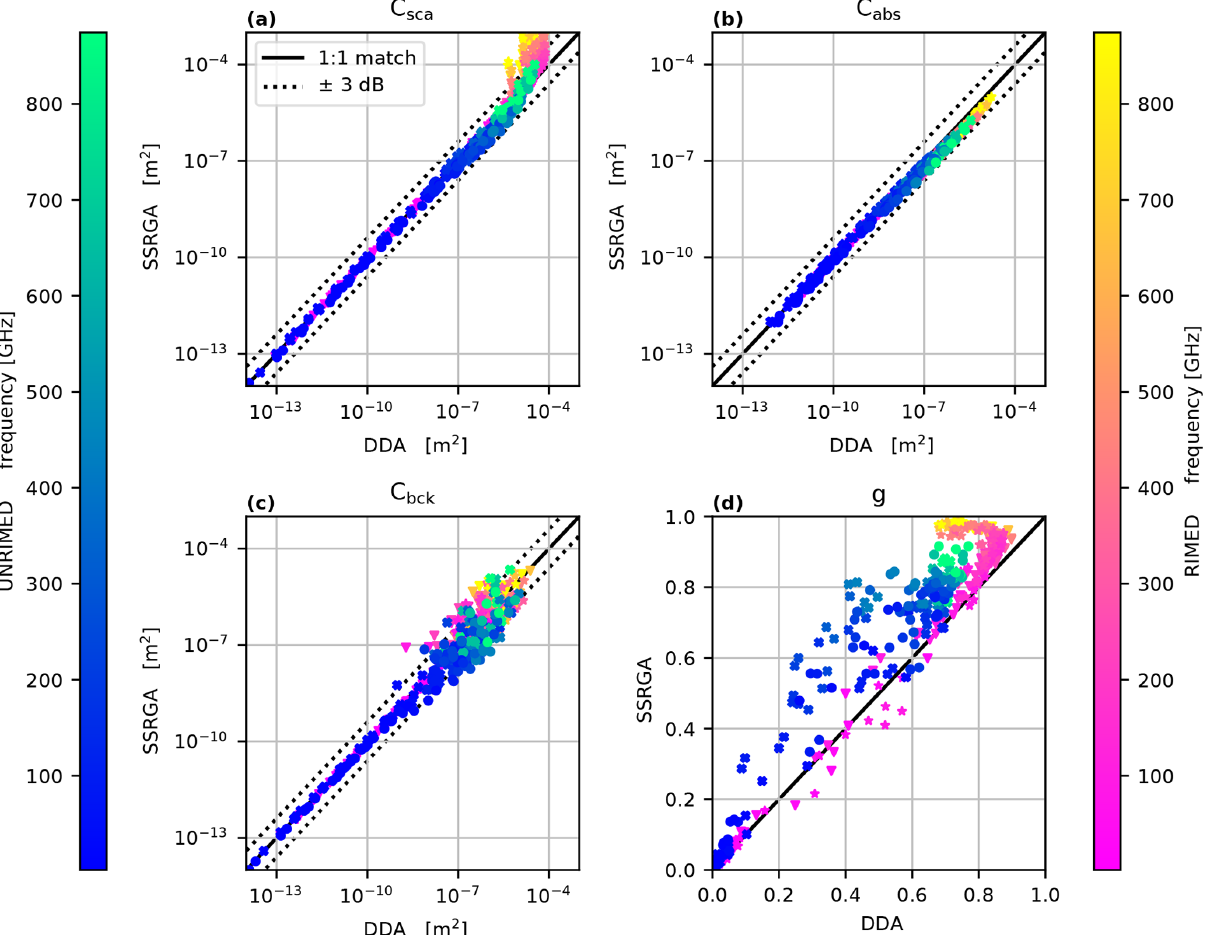
Figure 6. Comparison of microwave absorption and scattering properties of single snowflakes calculated with SSRGA and DDA methods. The compared quantities are the total scattering cross section C sca (a) , the absorption cross section C abs (b) , the radar backscattering cross section C bck (c) , and the asymmetry parameter g (d) . The frequency color scales (highest frequency included is 874GHz) are separated for rimed and unrimed particles to facilitate distinguishing between the two particle categories. The unrimed particles are aggregates of needles and aggregates of mixtures of columns and dendrites with sizes ranging from 4 to 20mm. The rimed particles are dendrite aggregates taken from the Leinonen and Szyrmer (2015) database in mode B (subsequent aggregation and riming) assuming an equivalent liquid water path (ELWP) of 0.5 and 1.0kgm − 2 . In panels (a) , (b) , and (c) two dotted lines mark the ± 3dB range of variation from the perfect